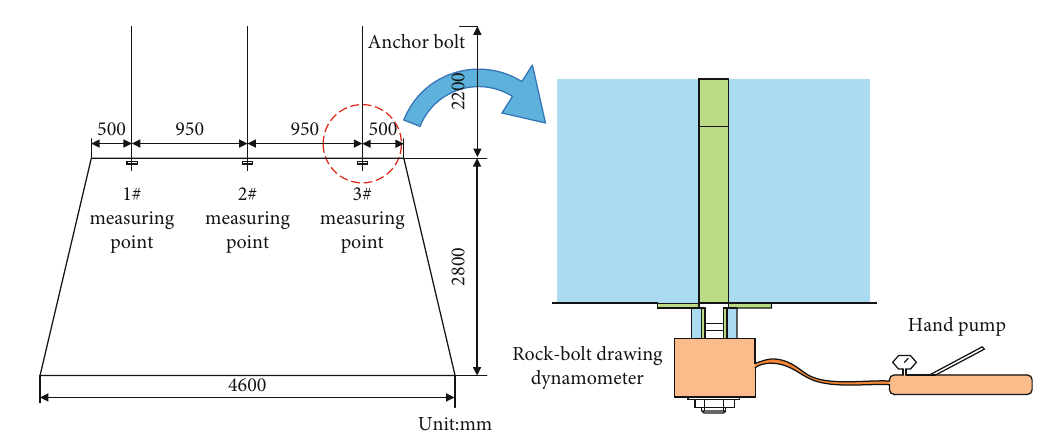
Figure 4: Arrangement of measuring points for bolt pull-out test.